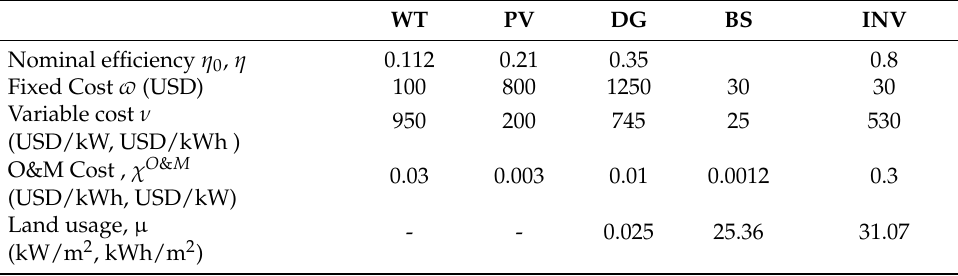
Table 3. Technical parameters for the technologies